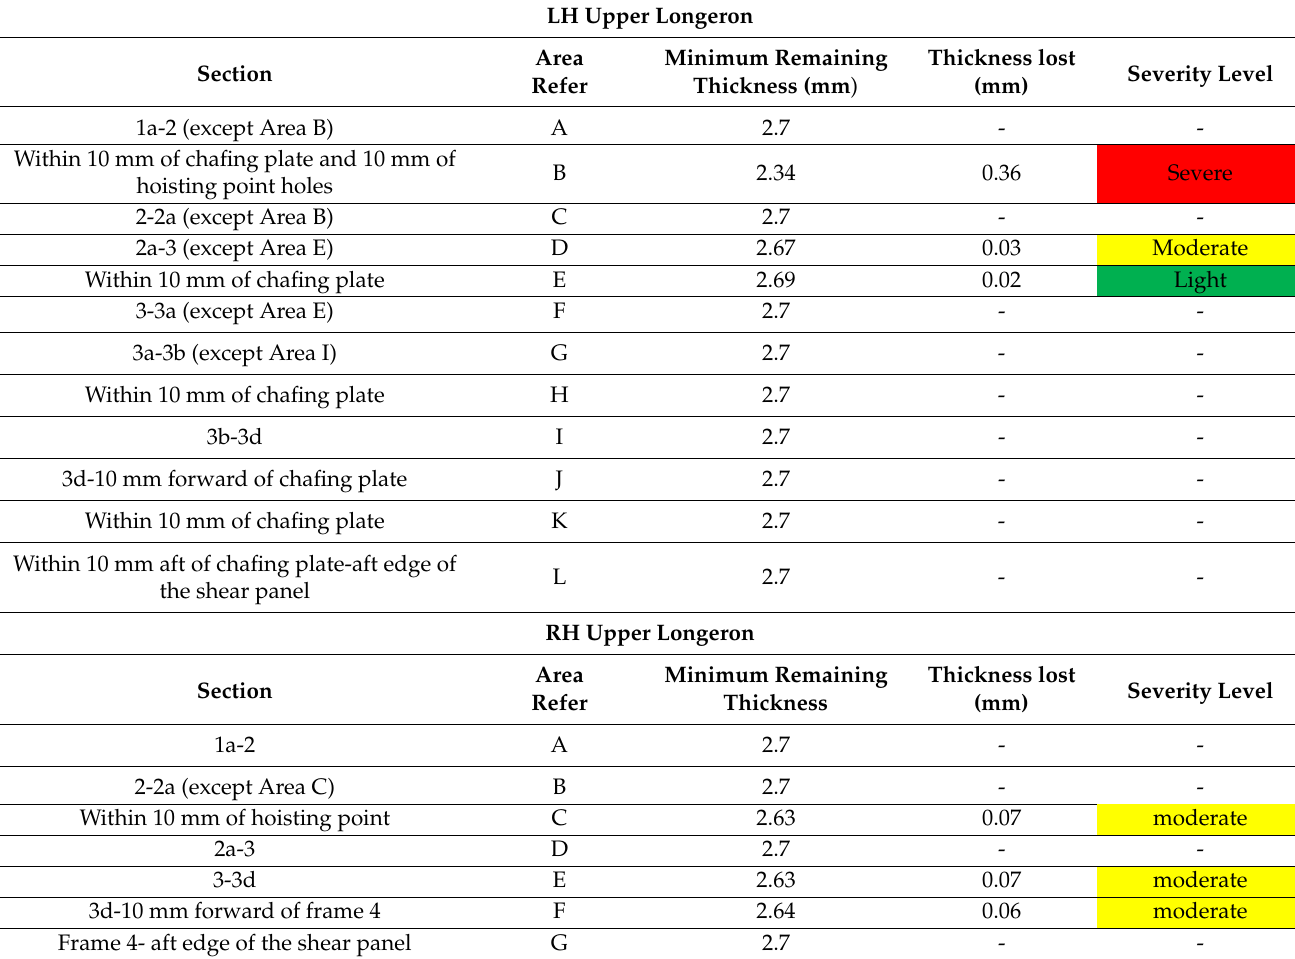
Table 2. Inspection result for RH and LH upper